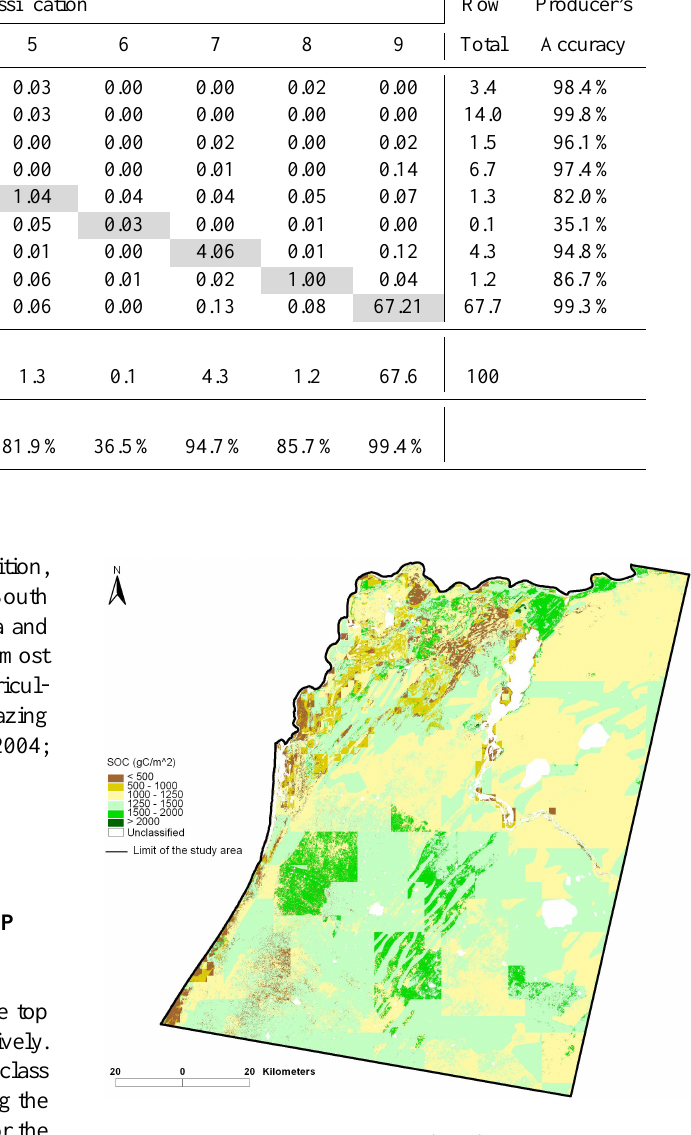
Fig. 3. GEMS soil organic carbon (SOC) model output for 2000 using the 9 class 28.5m Landsat hard decision tree